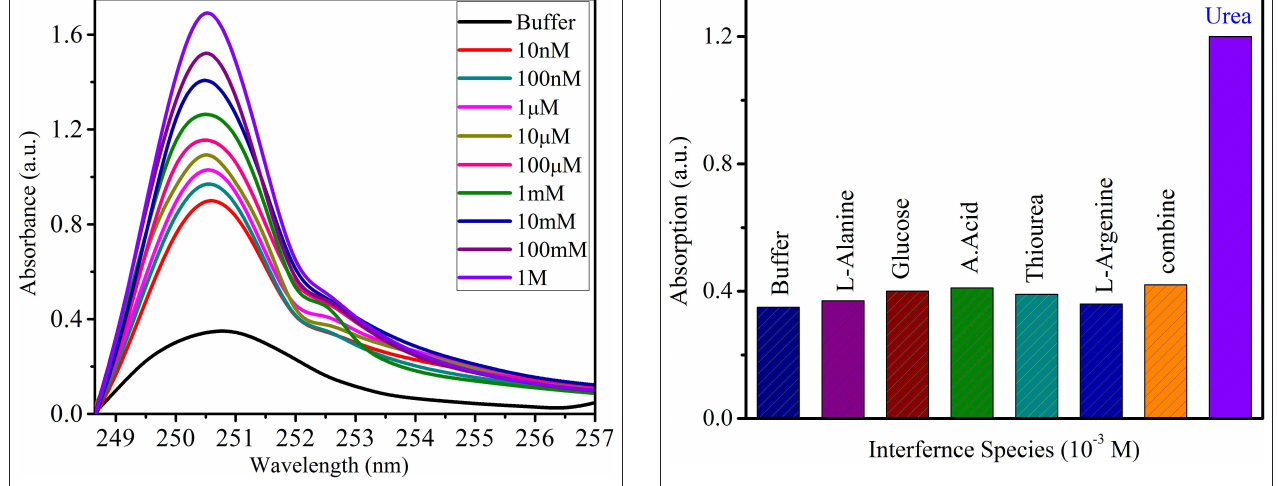
FIGURE 8 | Selectivity of developed biosensor.